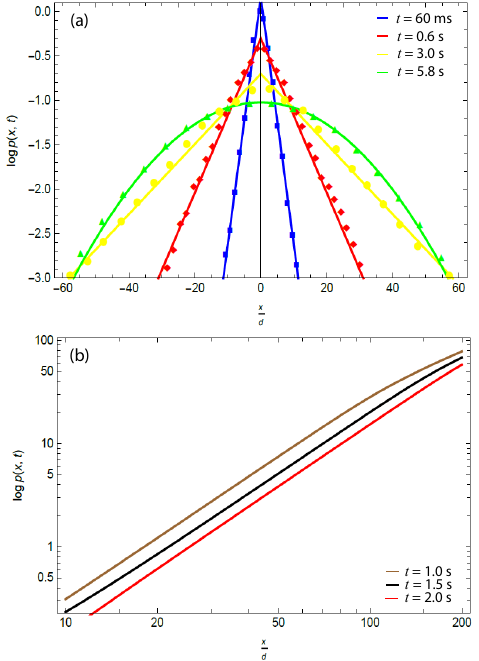
Figure 3. ( a ) Solid line curves obtained from the model and experimental data points of the logarithm of the displacement probability distribution plotted against particle displacement normalized by the particle diameter d at different times. ( b ) Theoretical prediction of the logarithm of the dis- placement probability distribution plotted against particle displacement normalized by the particle diameter d at a log–log scale at different intervals of times. These intervals of times are measured with respect to an initial time of t c = 4